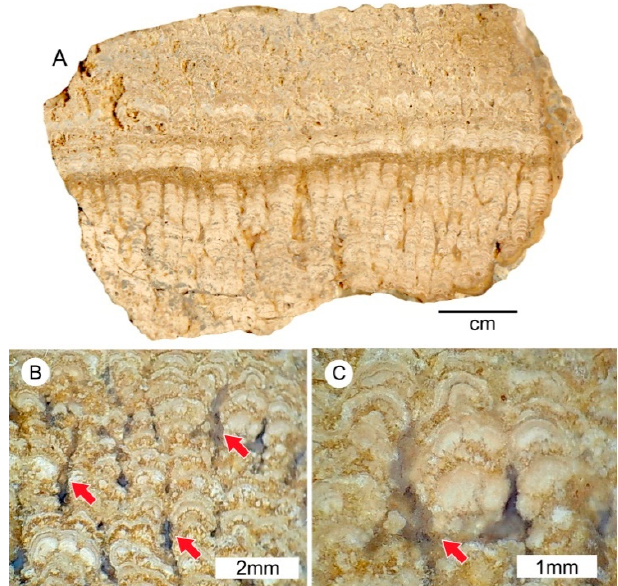
Figure 7. ( A – D ) Fossil limbs encased in stromatolitic coatings.